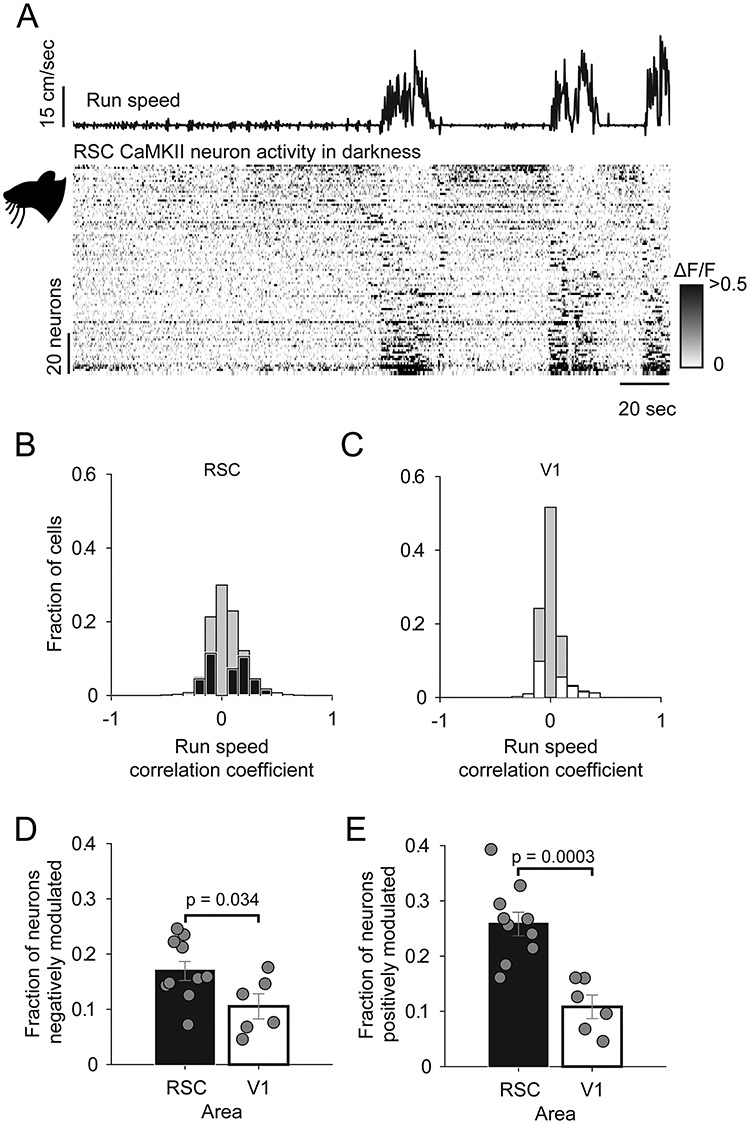
Comparison of the activity of CaMKII RSC and V1 neurons in darkness. (A) Run speed, and below, raster representation of neural activity (rows are individual neurons) sorted by run speed correlation. (B,C) Histogram of run speed correlations of RSC neurons (B, black) and V1 neurons (C, white) with the nonsignificantly correlated fraction of neurons (determined with shuffle test) represented by gray bars. (D,E) Mean fraction of neurons which are significantly negatively locomotion correlated (D) or positively locomotion correlated (E). Error bars indicate SEM.